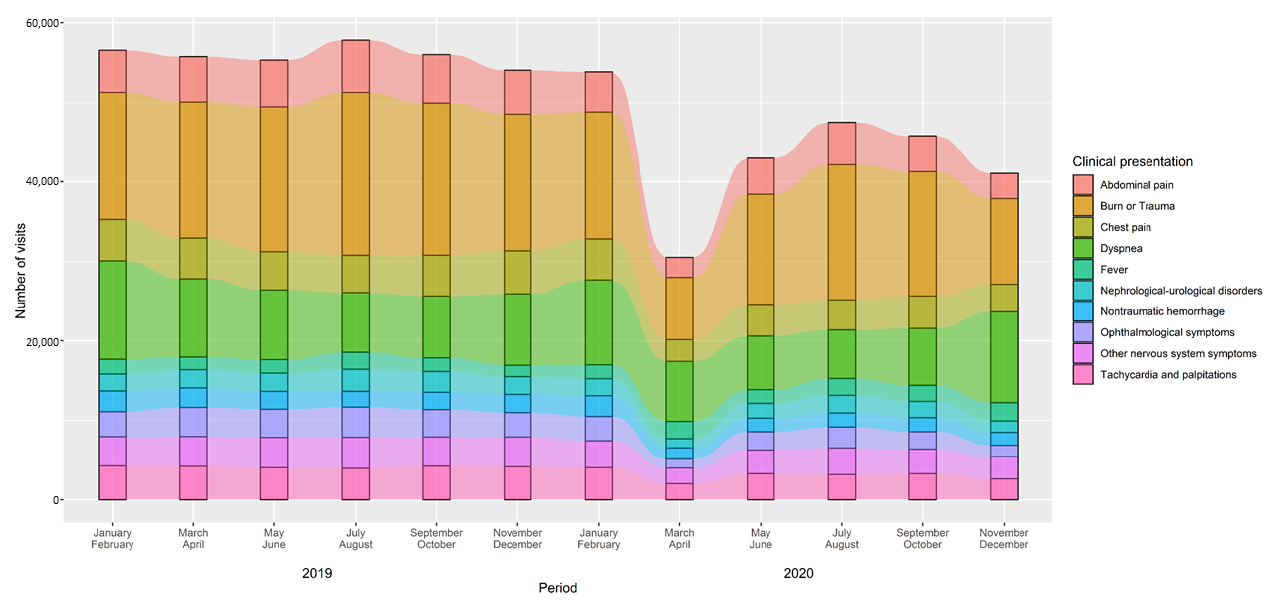
Figure 3. Trend in number of emergency department visits for the most common clinical presentations (chief complaints), 2019–2020 among people aged 65 or over. Not specified or missing clinical presentations were excluded from the analyses.